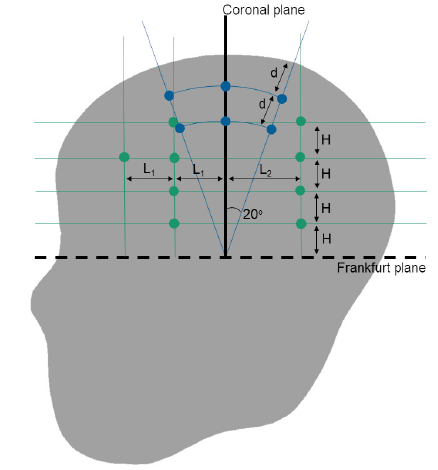
Figure 4. Illustration of the NDT implantation pattern used by Guettler et al. [39]. The radial arrangement (blue) has NDTs implanted at 20 mm depth intervals measured from the outer surface of the skull (d) radiating 20 ◦ anterior and posterior from the mid coronal plane and is implemented in the left hemisphere of the brain. The grid arrangement (green) places columns of NDTs spaced 1/3 of the distance from the mid coronal plane to the anterior edge of the skull (L 1 ) and half way between the mid coronal plane and the posterior limit (L 2 ). The space between the rows of each column is 1/6 of the height from the Frankfurt plane to the outer skull surface at the mid coronal plane